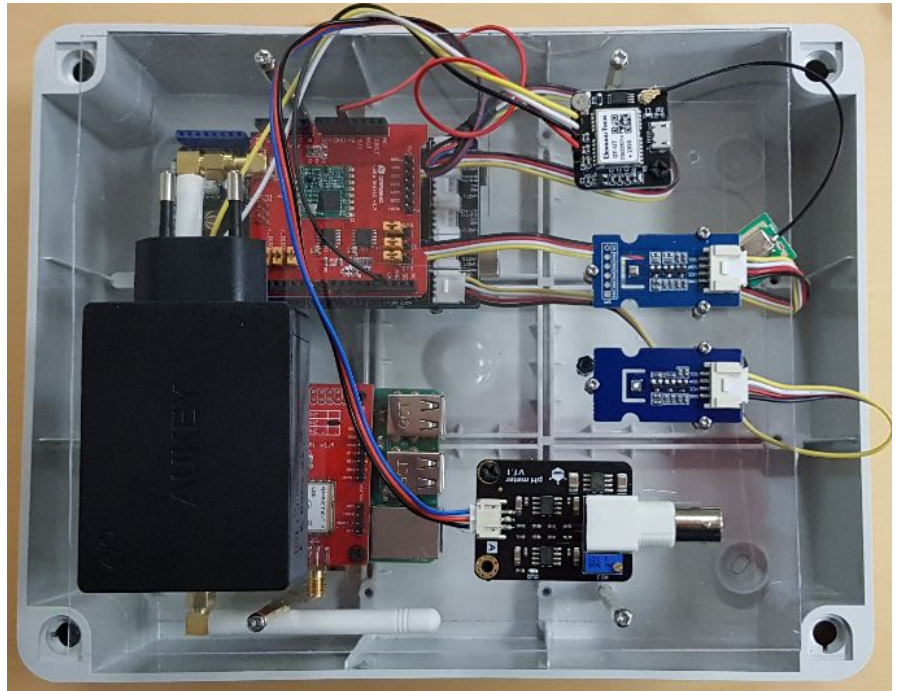
Figure 2. Photo of the commercial devices during assembly. The depicted devices are housed in a water tight enclosure along with the glyphosate detection